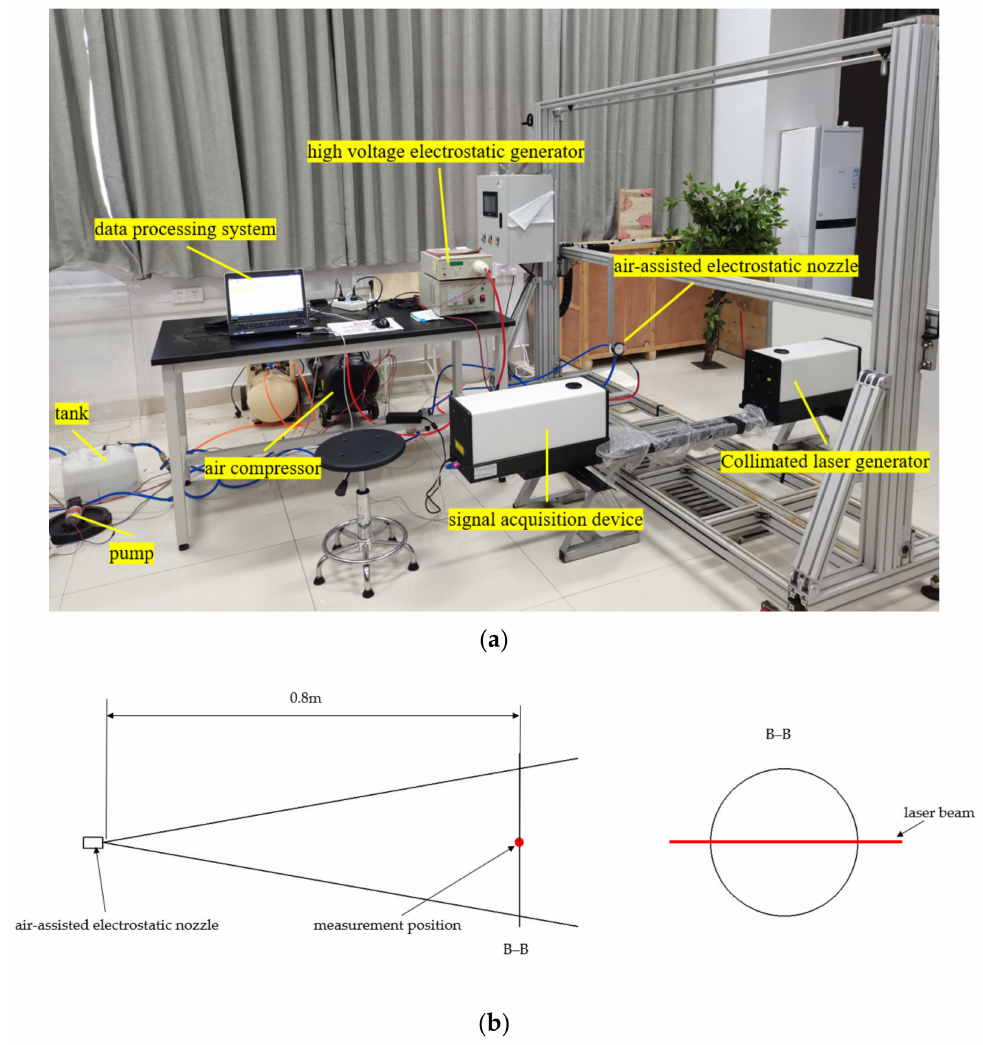
Figure 3. ( a ) Experimental set-up to measure the droplet size, ( b ) Schematic sketch of measuring position in the spray